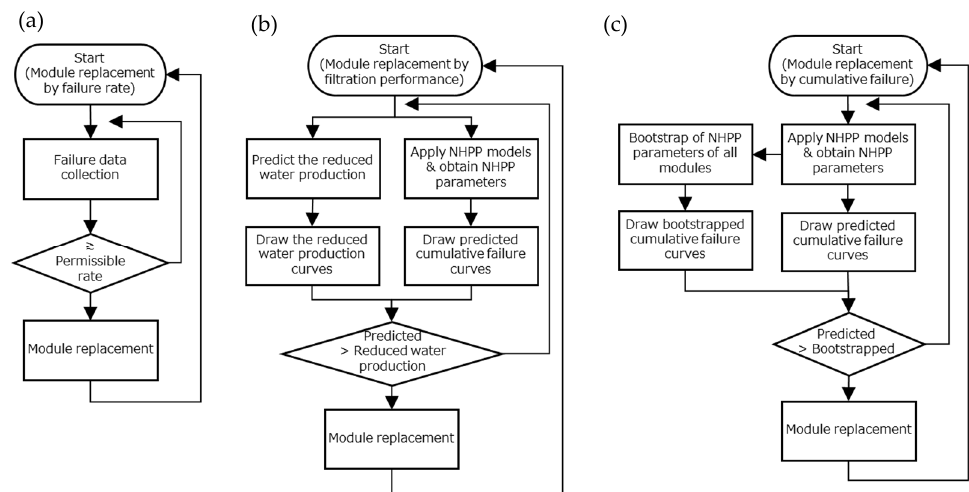
Figure 6. Flow charts of membrane module replacement. (a) replacement by failure rate; (b) replacement by filtration performance; and (c) replacement by cumulative failure.